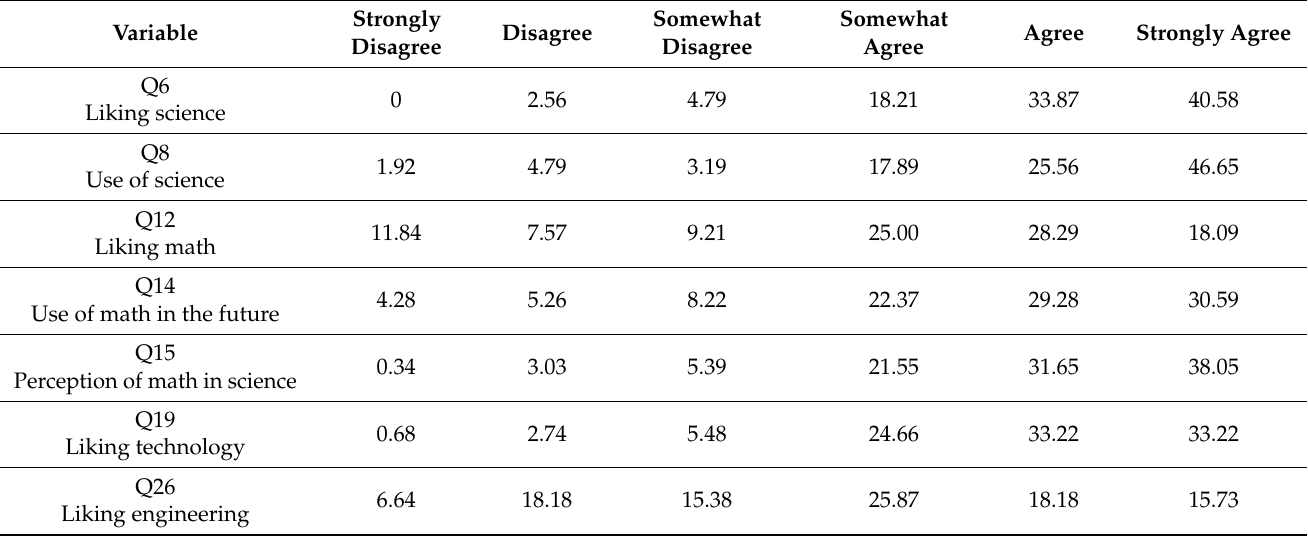
Table 5. Percentage of responses of